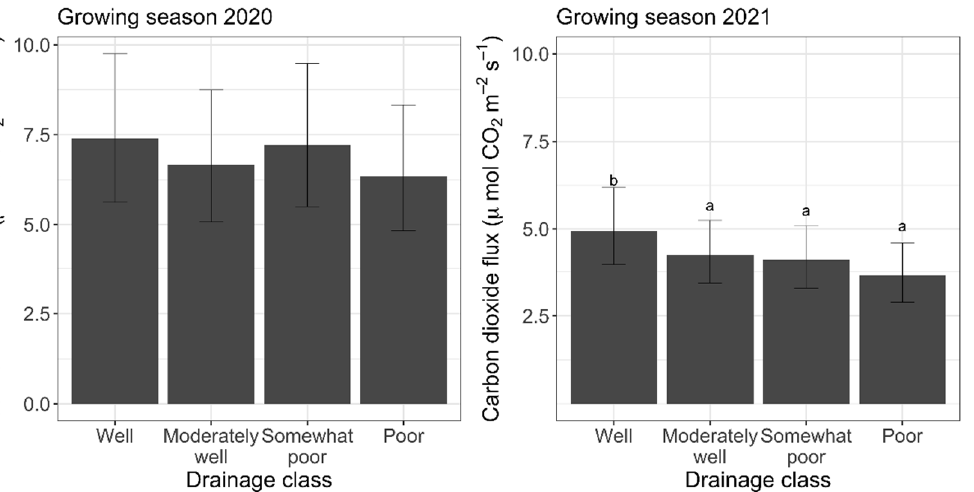
Figure 4. The least square mean values of bulk soil respiration by drainage class for 2020 and 2021. Letters represent significant differences between the drainage classes within a specific year ( p -value < 0.05). Error bars represent 95% confidence intervals .